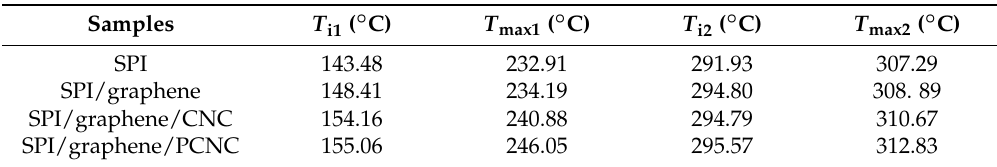
Table 4. Thermal degradation data of SPI film and SPI-based films modified with graphene, CNC, and